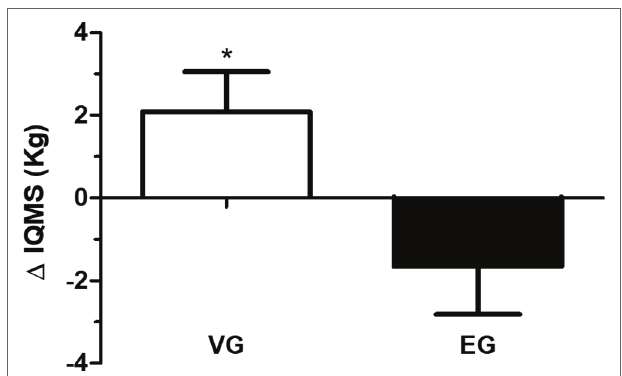
FIGURE 2 | The delta (Δ) in isometric quadriceps muscle strength (IQMS) in the vibration group (VG) and exercise group (EG). The data are presented as the mean and standard error. *VG is significantly different from EG ( p ≤ 0.05). Data are presented in delta (Δ), i.e., the variation between the values measured before and after the intervention period (independent t -test).